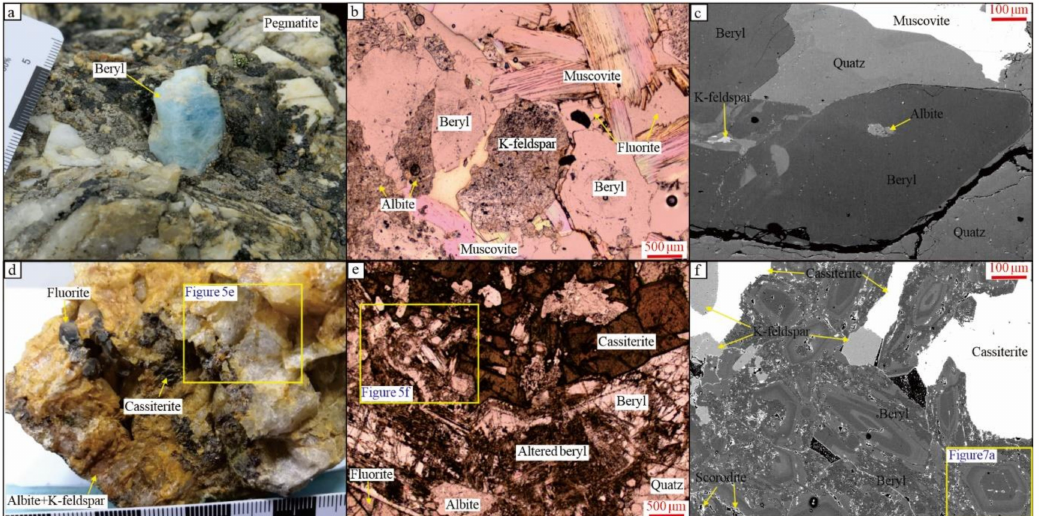
Figure 5. Occurrence characteristics of beryl in the Xianglin area. ( a ): Beryl-bearing pegmatite. ( b ): beryl co-existing with quartz, plagioclase, K-feldspar, muscovite and fluorite (plane-polarized light). ( c ): beryl co-existing with quartz, plagioclase, K-feldspar, muscovite (BSE image); ( d ) Beryl- and cassiterite-bearing hydrothermal vein. ( e ) Beryl with band structure, associated with cassiterite, quartz, muscovite and albite (plane-polarized light). ( f ): Beryl with complex zonal structures, associated with cassiterite, K-feldspar, quartz, muscovite, albite and scorodite (BSE